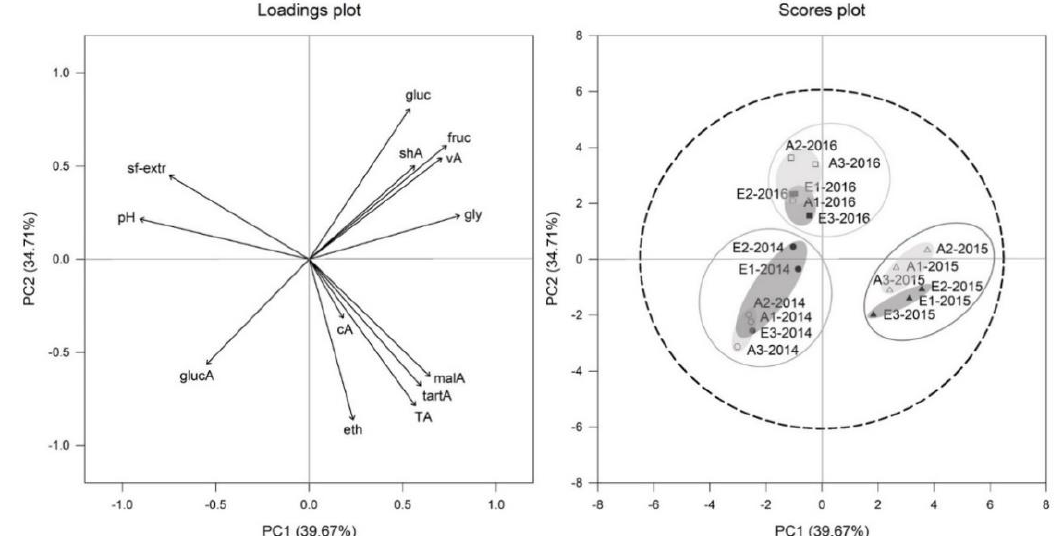
Figure 4. Loadings and scores plot of principal component analysis (PCA) of Riesling must parameters from aCO 2 (open symbols) and eCO 2 (filled symbols) treatment for the years 2014 (circles), 2015 (triangles) and 2016 (squares). Data represent values per ring and p = 0.95 for confidence level (dashed line).